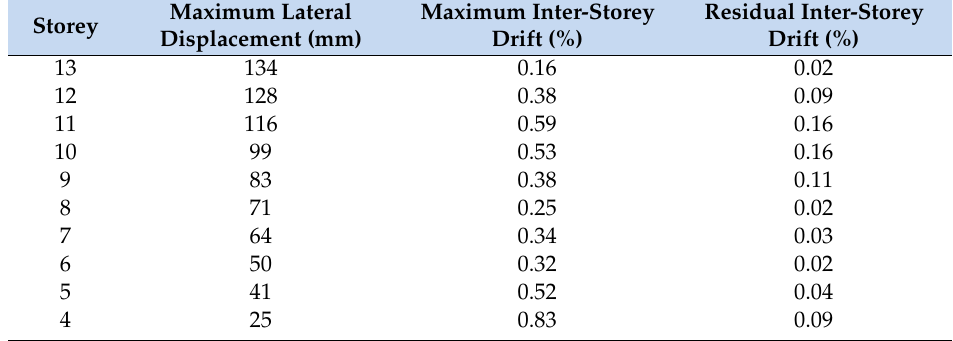
Table 11. Results from reduced rotation base sti ff ness for the whole building with slab model including KHC and IHC for the ULS case.